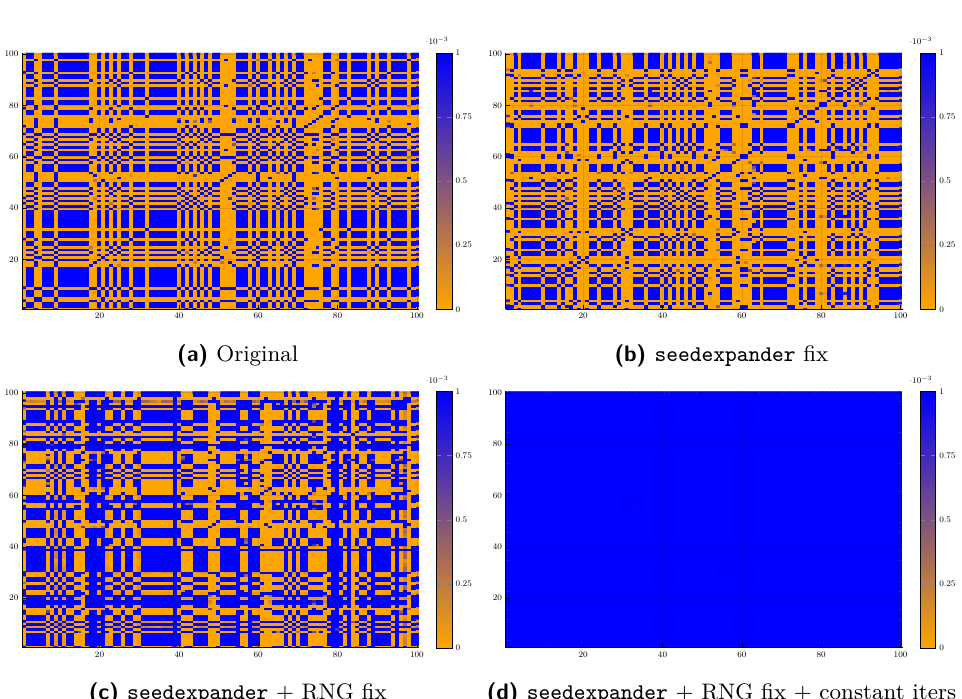
Figure 9: P-values for Welch’s t-test testing whether there is a statistically significant difference between the computation time of the part invoking the Sample function in the re-encryption of the decapsulation for each pair in 100 ciphertexts generated for a single keypair. Orange indicates that a statistically significant difference was detected. The final countermeasure eradicates all statistically significant timing differences in the Sample